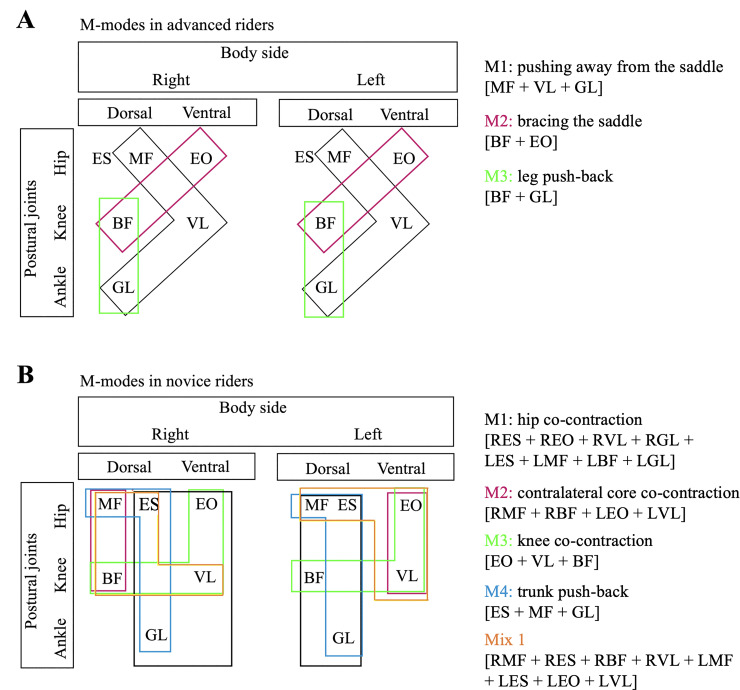
Diagram of the classification of muscle modes (M-modes) based on PCA results.Four reciprocal modes were identified in the advanced group (A). One reciprocal mode, three co-contraction modes and one mixed mode (B) were identified in the novice group.